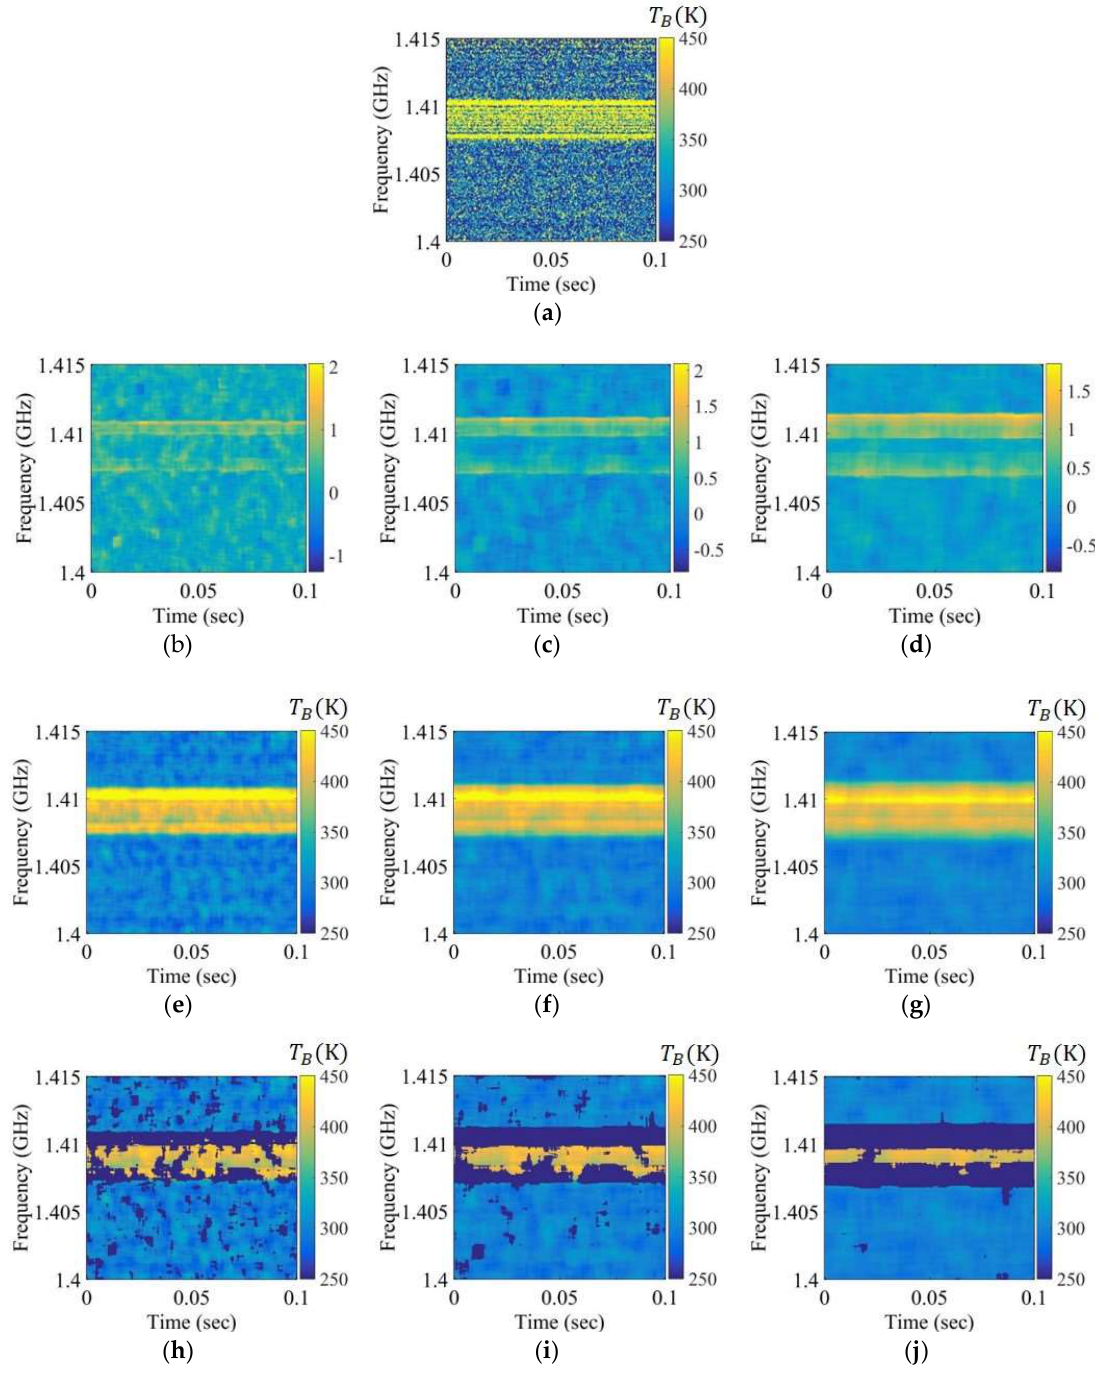
Figure 9. Spectrograms applied to the chirp RFI signal to a level below approximately 100 K over the entire 1.407 to 1.411 GHz band: ( a ) brightness temperature spectrogram after smoothing; ( b – d ) skewness spectrograms obtained using the window sizes of 50 × 50, 75 × 75, and 100 × 100, respectively; ( e – g ) mean spectrograms obtained using the window sizes of 50 × 50, 75 × 75, and 100 × 100, respectively; ( h – j ) mean spectrograms after Step 1 obtained using the window sizes of 50 × 50, 75 × 75, and 100 × 100, respectively.